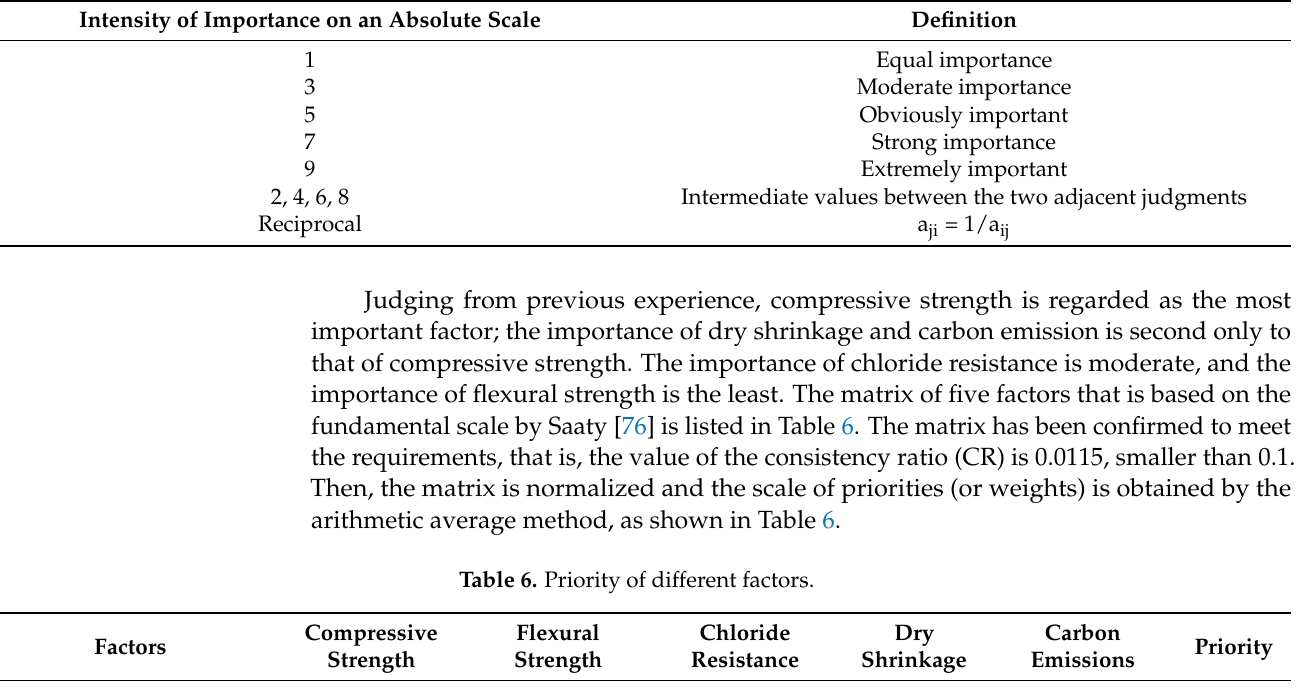
Table 5. The fundamental scale by Saaty. Reproduced with permission from [76]. Copyright Elsevier, 1987. Intensity of Importance on an Absolute Scale